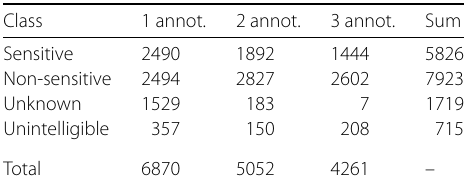
Table 3 Details of the annotations. The last column contains the number of posts receiving at least one annotation for each class